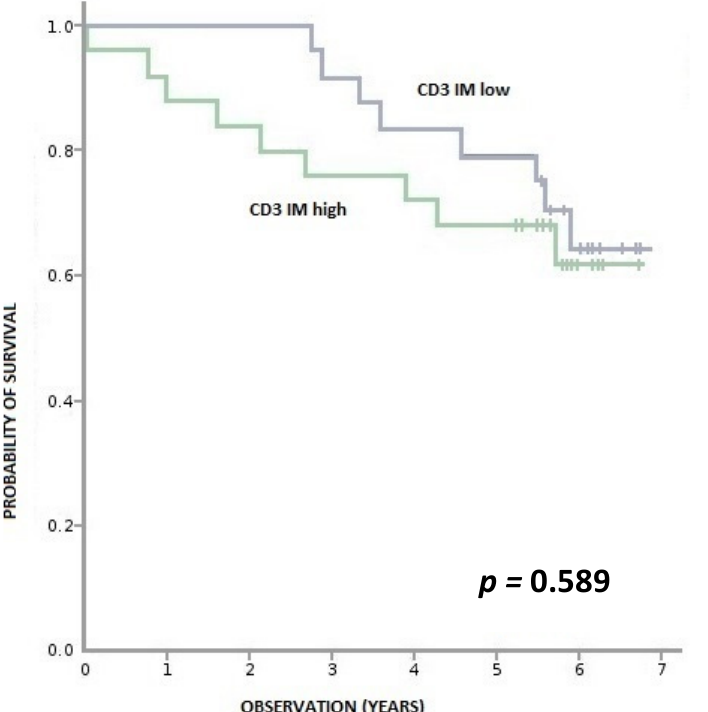
Figure A1. Overall survival according to density of CD3+ lymphocytes in IM (invasive margin). CD3+ IM high— ≥ 970 per 0.56 mm 2, CD3+ IM low—< 970 per 0.56 mm 2 .